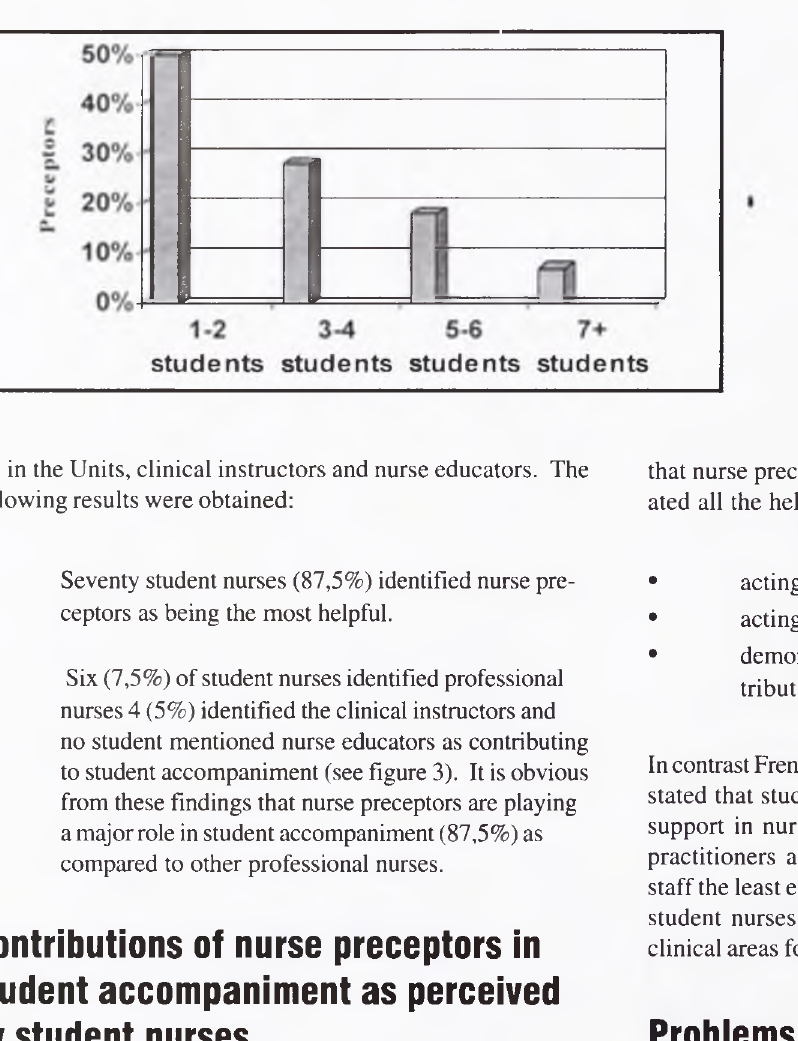
Figure 2: Number of student nurses supervised by nurse preceptors per